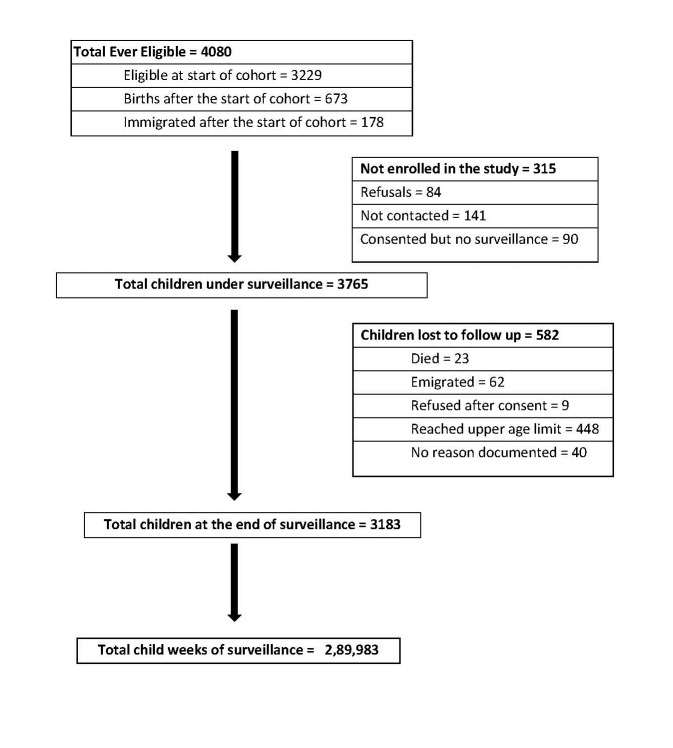
Flowchart depicting the assembly and follow-up of cohort.